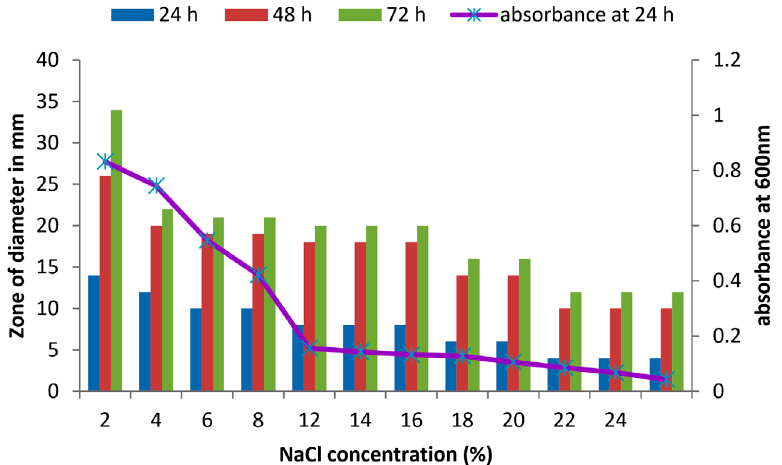
Fig. 4. Effect of NaCl on growth and DNase production of KVCMST-6A20.The zone of clearance in DNase test agar at various time of incubation indicated by bars: 24 hours, 48 hours, 72 hours and its growth indicated by its absorbance at 24